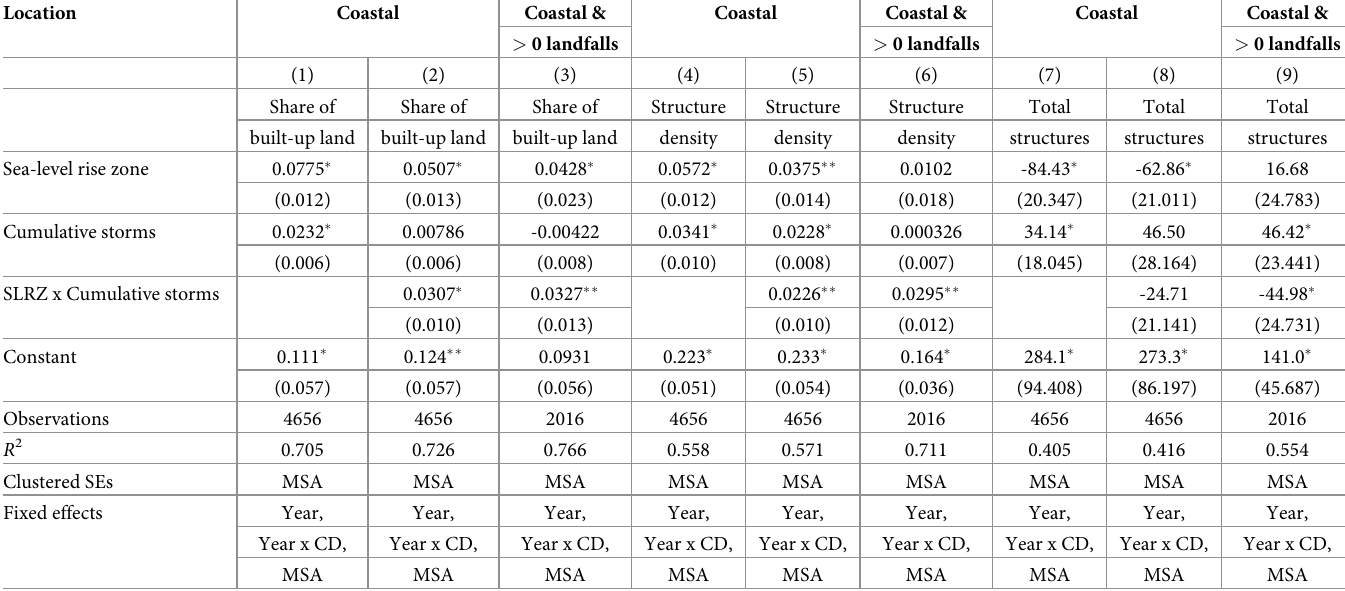
Table 1. Built environment and cumulative storm hits panel regression analysis from 1900–2015.